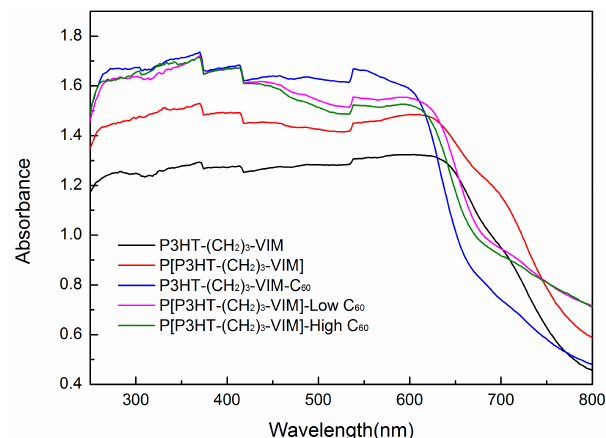
Figure 13. Solid state UV-Vis spectra of P3HT-(CH 2 ) 3 -VIM, P[P3HT-(CH 2 ) 3 -VIM], P3HT-(CH 2 ) 3 -VIM-C 60 , P[P3HT-(CH 2 ) 3 -VIM-C 60 -low], and P[P3HT-(CH 2 ) 3 -VIM-C 60 -high].